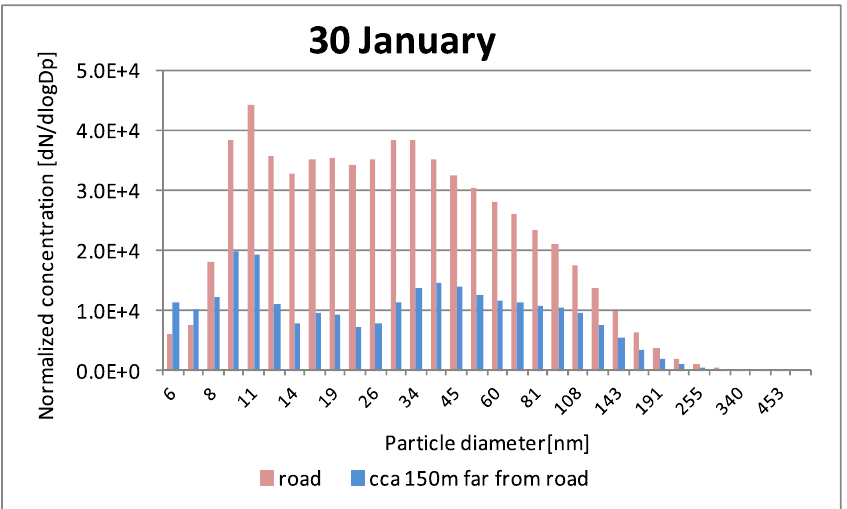
Figure 15. Particle number distributions during simultaneous measurement by two instruments sets, one near the main road, the second ca. 150 m away from the road on 30 January, 7:30–8:00 a.m., corresponding to blue dots in Figure 14a. Concentrations measured away from a main road in Celakovice had similar distribution as particles measured next to the main